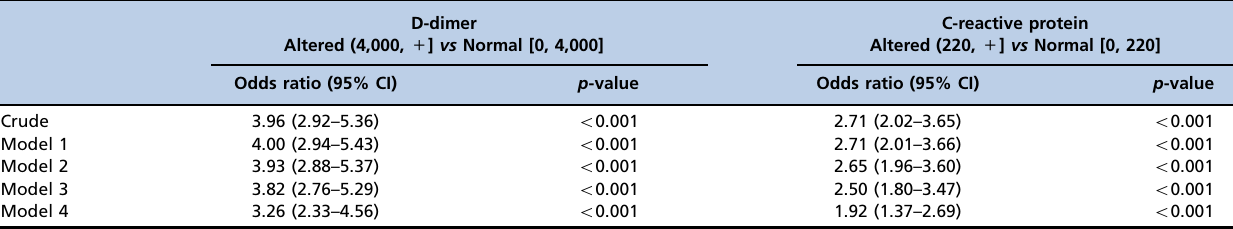
Table 3 - Crude and adjusted associations of D-dimer levels and C-reactive protein levels with imaging-confirmed venous thromboembolism.